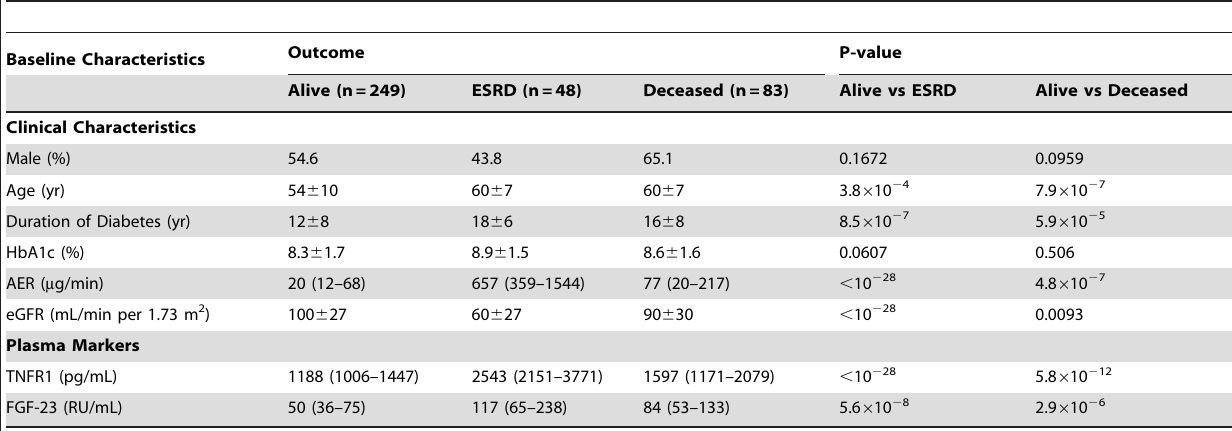
Table 1. Baseline characteristics of subjects with T2D according to their outcome during 8–12 years of follow-up.